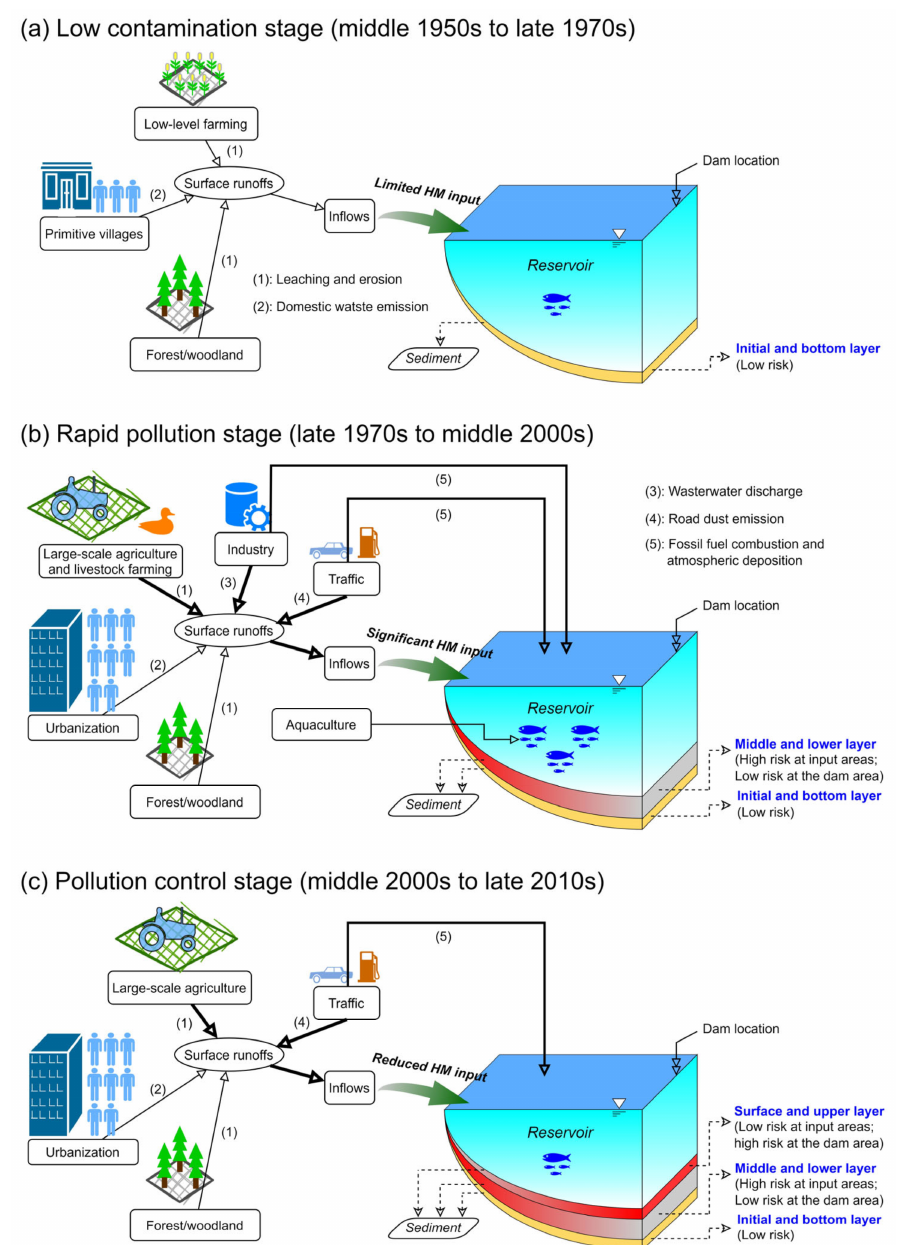
Figure 6. General pattern of heavy metal pollution processes in sediments of typical small- and medium-sized reservoirs: ( a ) low contamination stage, ( b ) rapid pollution stage, and ( c ) pollution control